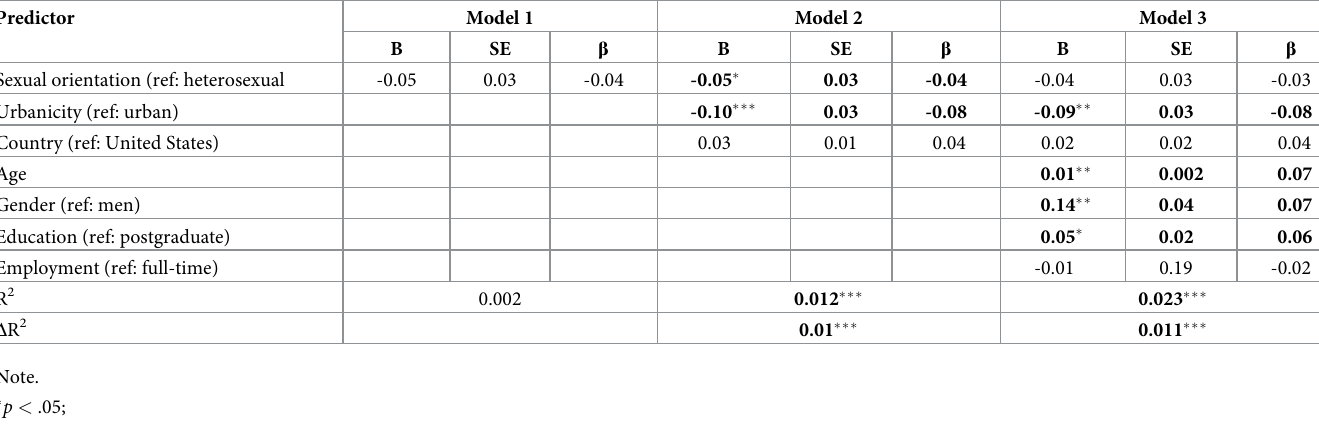
Table 5. Hierarchical linear regression of hand washing on sociodemographic predictors with standardized and unstandardized coefficients.